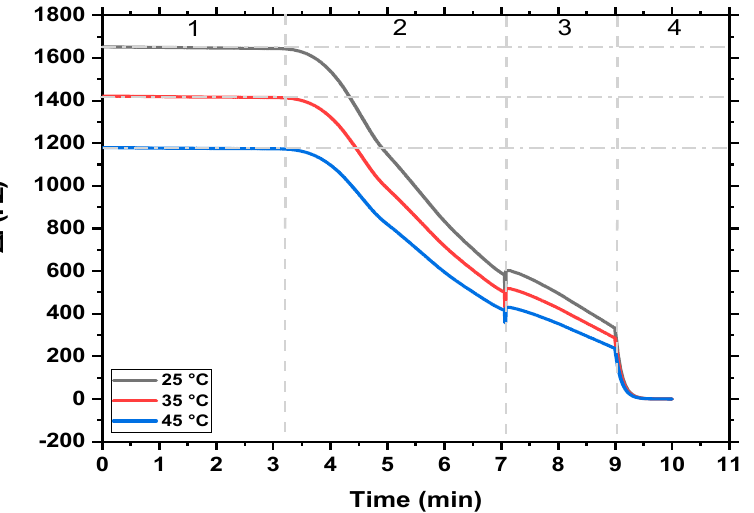
Figure 5. The real-time detection of MB dye (400 mg/L) by MgFe 2 O 4 @CaAlg NCs nanosensor at different temperatures (25 °C, 35 °C, and 45 °C); zone (1) shows the QCM monitoring of MgFe 2 O 4 @CaAlg NCs nanosensor, (2) indicates the monitoring of MB, (3) represents the adsorption of MB on the nanosensor surface, and (4) adsorption equilibrium of MB.